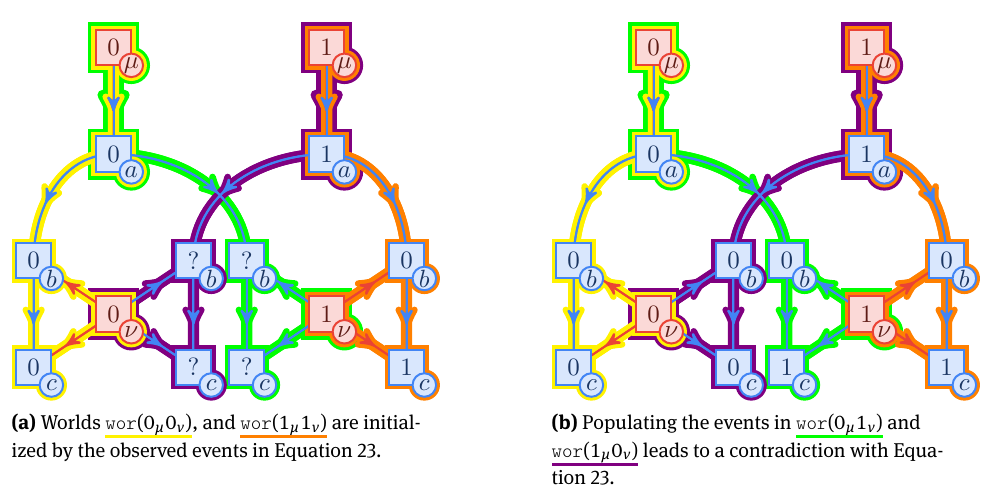
Figure 8: A possible worlds diagram for G 7 (Figure 7). The worlds are colored: wor (0 µ 0 ν ) yellow, wor (1 µ 1 ν ) orange, wor (1 µ 0 ν ) violet, wor (0 µ 1 ν )